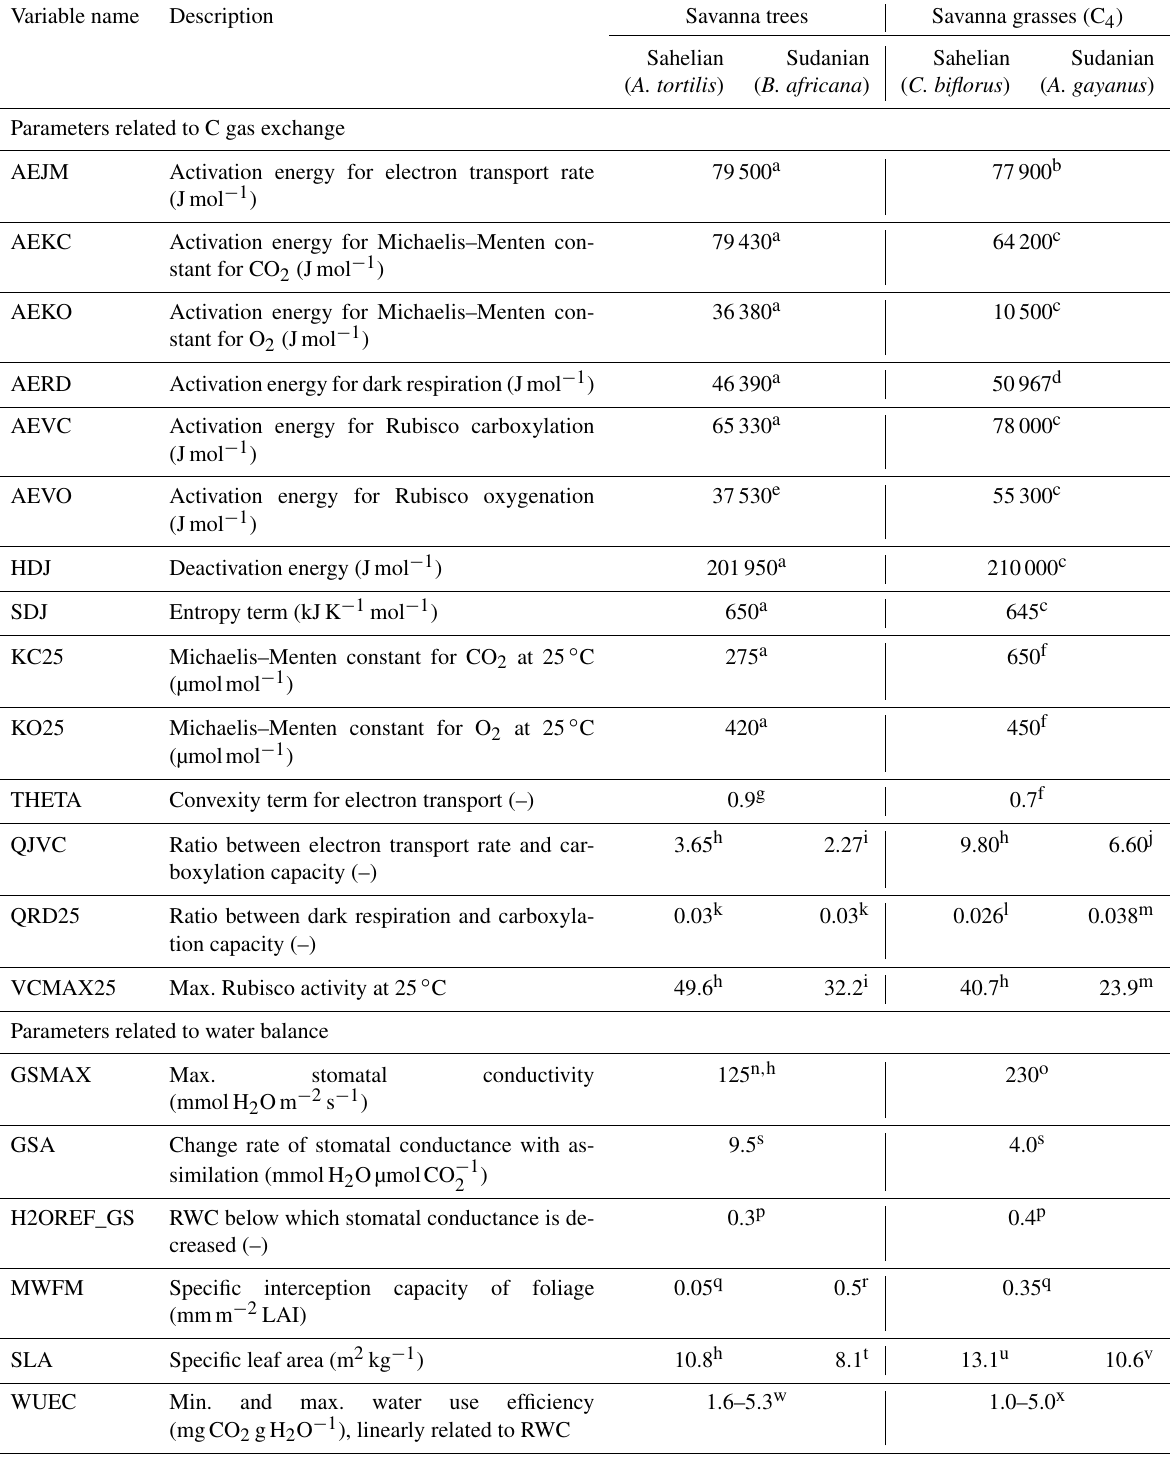
Table 2. Plant parameters affecting the C and water exchange in the PSIM vegetation model used for simulating biomass growth of natural savanna ecosystem